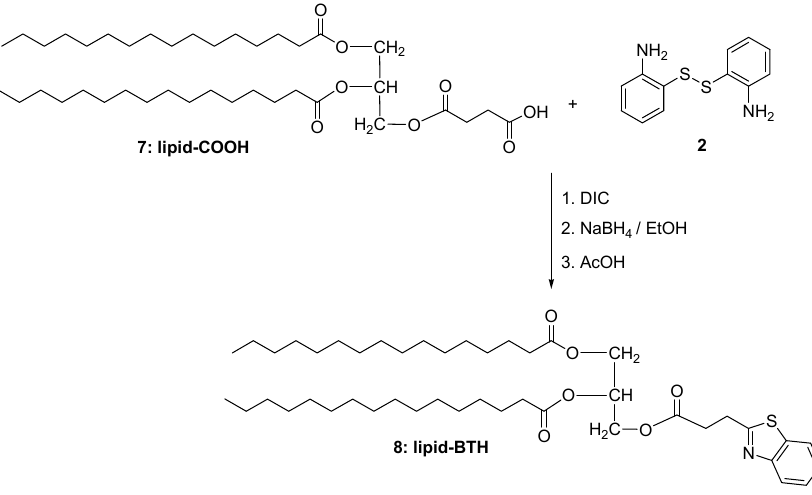
Scheme 4. Synthetic method for the formation of lipid-BTH.